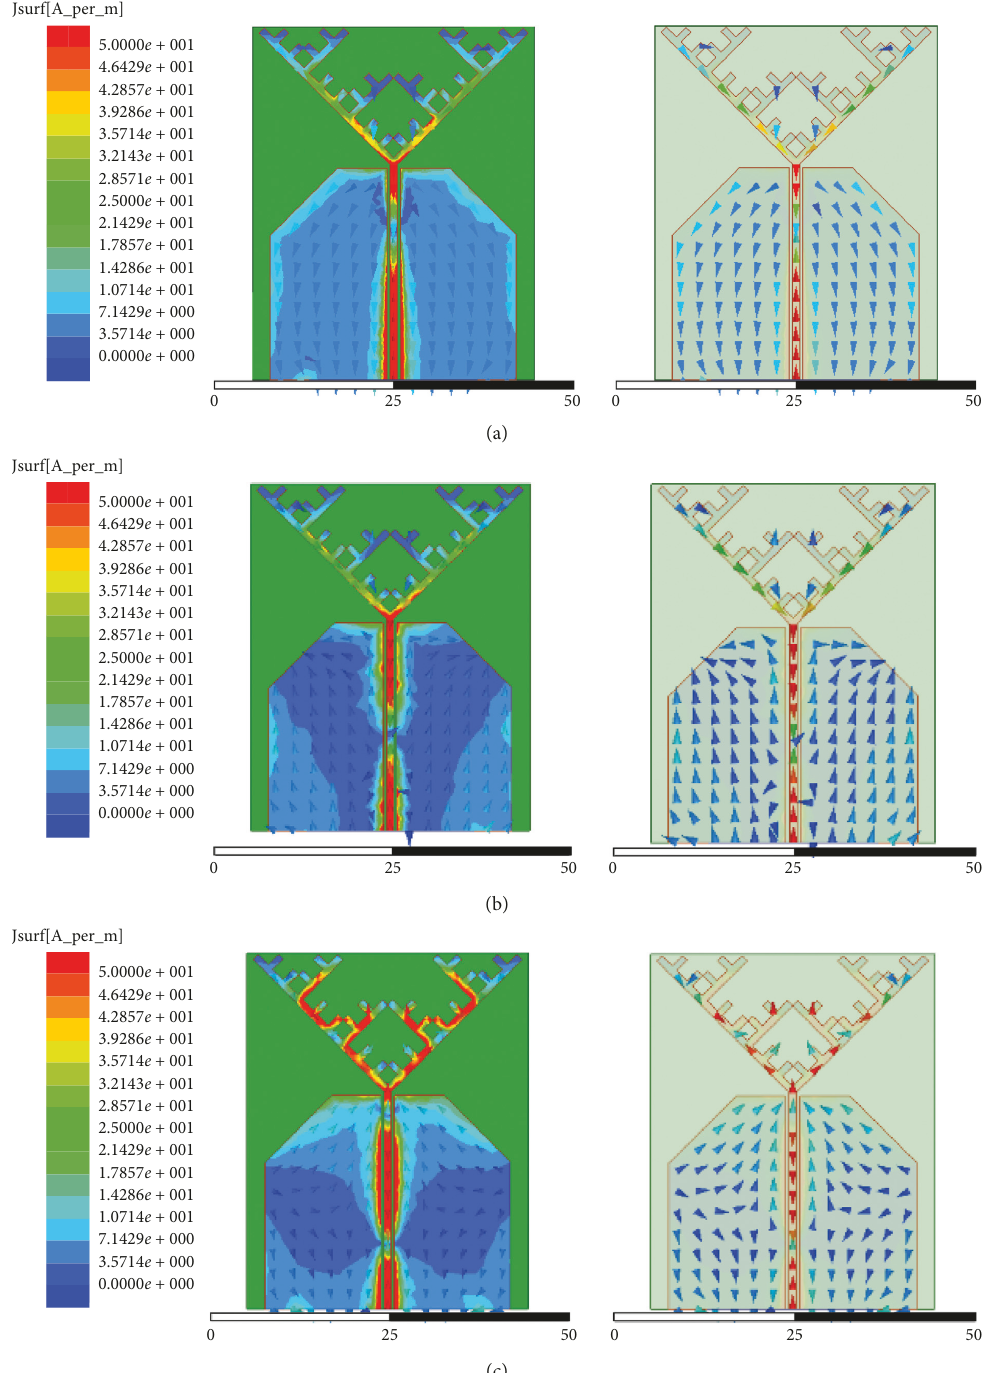
Figure 8: Surface current distribution in triple band modes. (a) 2GHz. (b) 3.25 GHz. (c)